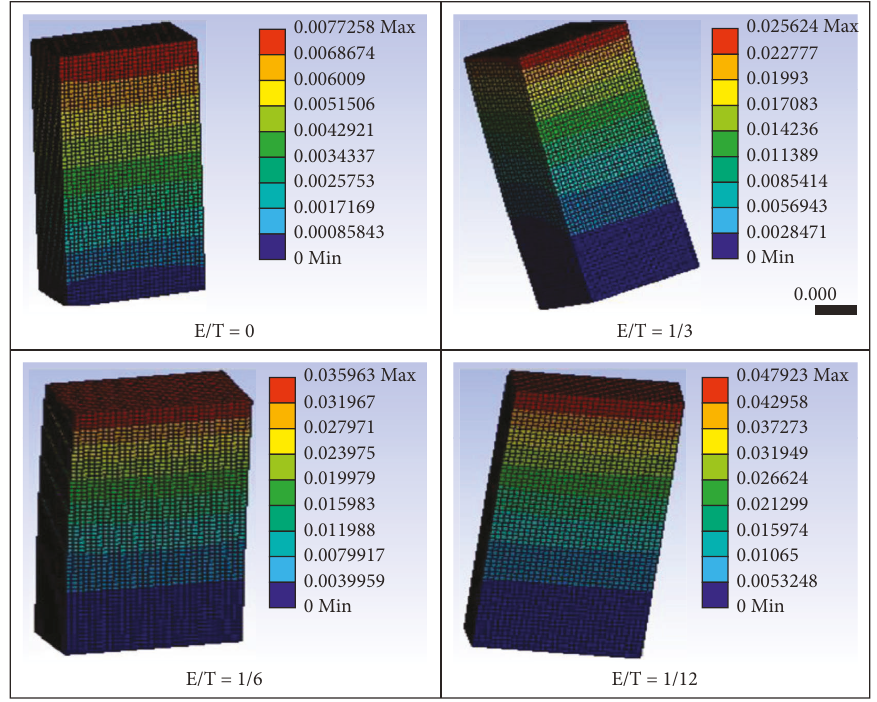
Figure 8: Deformation contours of specimens with H/T �